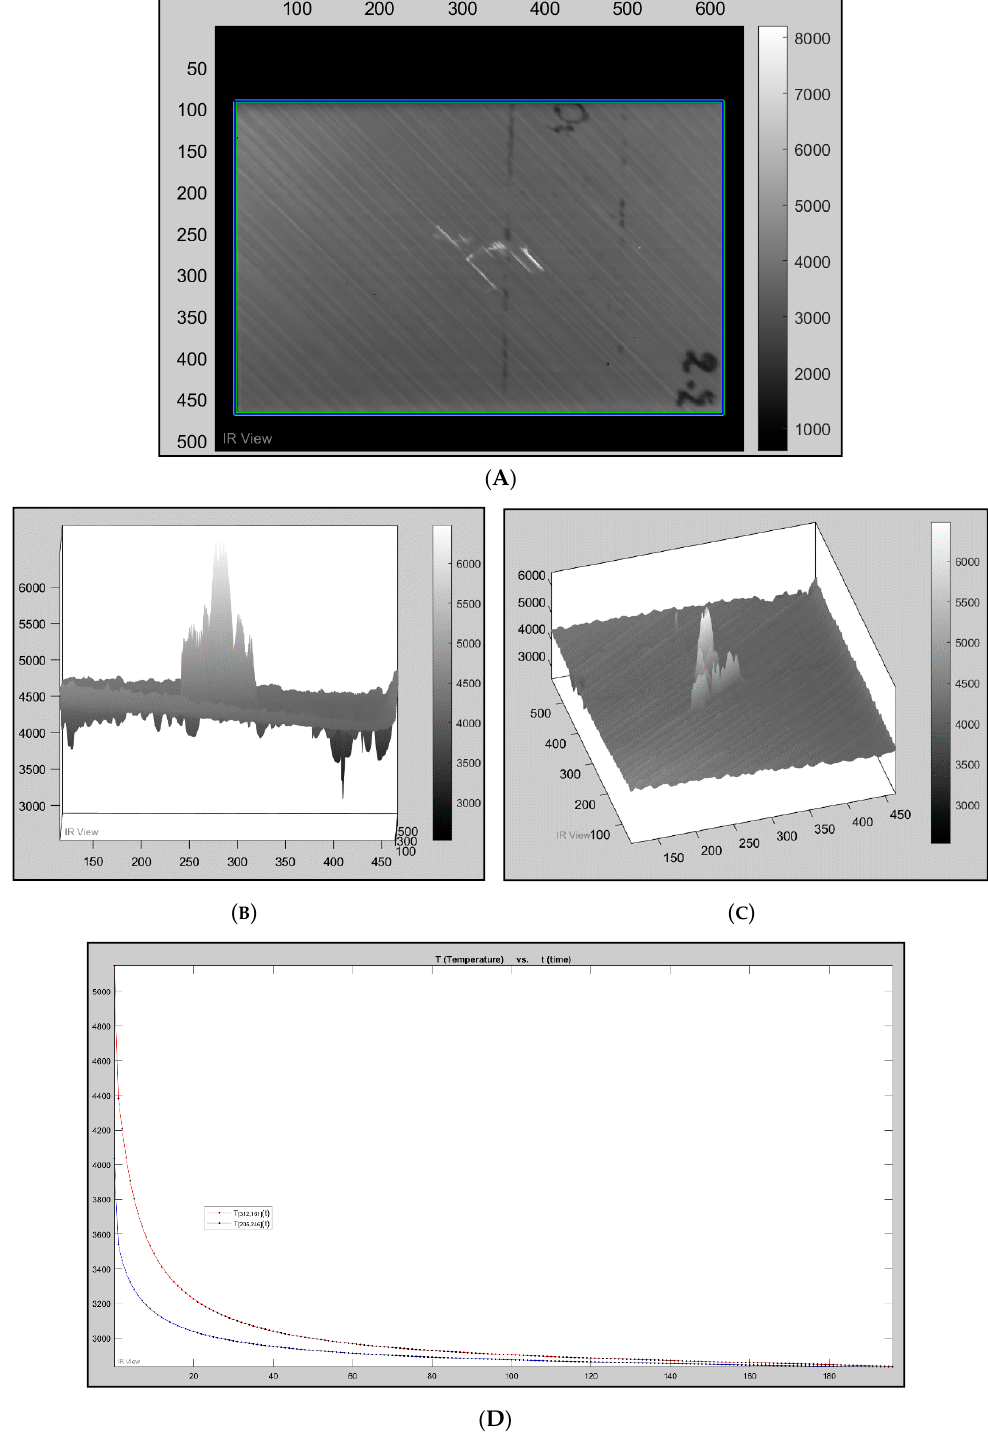
Figure 9. ( A ) 2.2CooledFront , frame 4, where the flash hit the specimen. ( B ) 2.2CooledFront , frame 4, where the flash hit the specimen. Three-dimensional (3D) pixel map side angle. ( C ) 2.2CooledFront , frame 4, where the flash hit the specimen. 3D pixel map top angle. ( D ) Temperature vs. time graph; the black dots each represent a frame (blue—sound pixel; red—defected pixel). The fourth frame in dataset 2.2CooledFront is where the electromagnetic radiation from the flash hit the specimen, and the damage can be seen instantly. Figure 9D is a temperature / time graph,